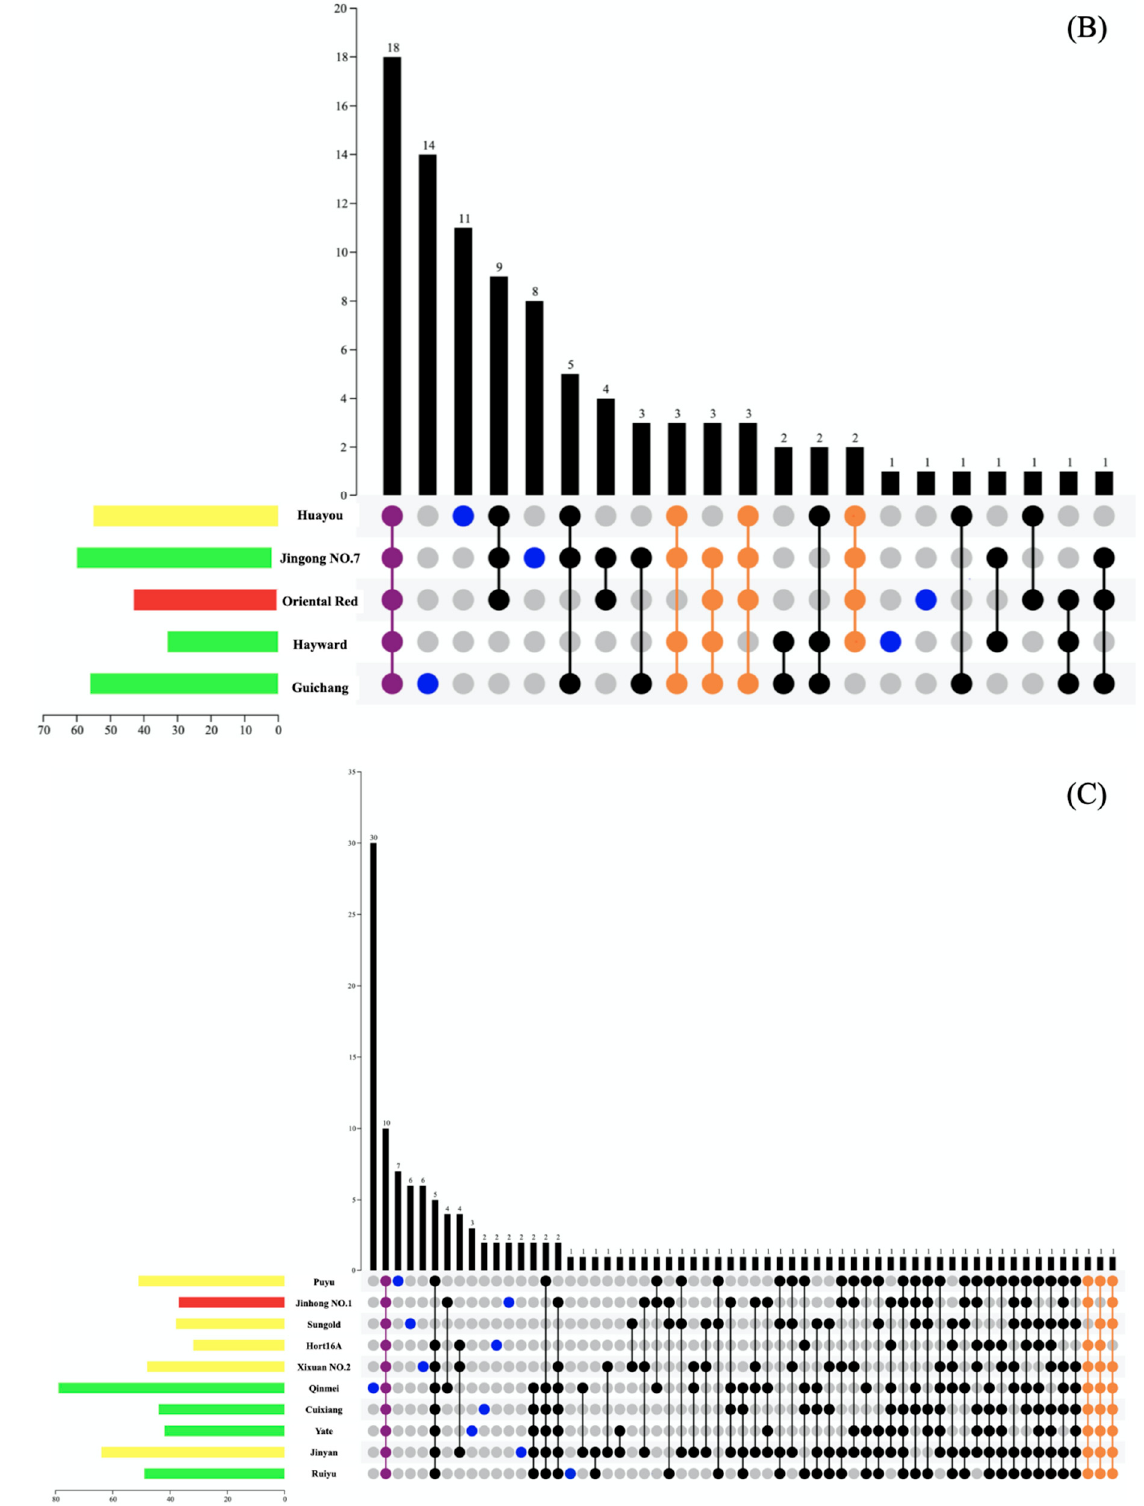
Figure 4. Venn diagrams for the analysis of volatile components in kiwifruit samples of different types (three major categories ( A – C ) based on the E-nose response). The length of the histogram on the left represents the number of volatile components in different kiwifruit cultivars, and the color represents the color of the kiwifruit flesh, namely, green-, yellow-, and red-flesh kiwifruit. The dot chart below represents the number of common volatile components in different kiwifruit cultivars.